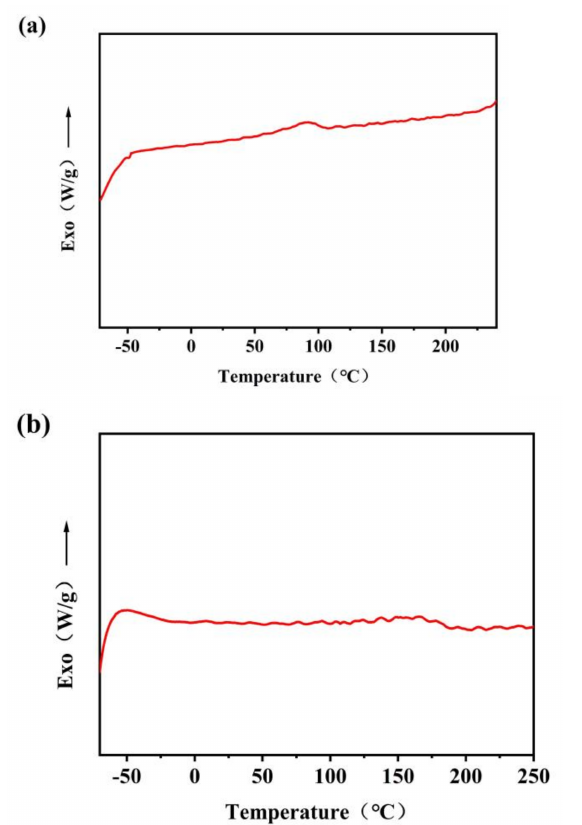
Figure 3. Differential scanning calorimetry (DSC) curves of TPSiU. ( a ) cooling curve. ( b ) secondary heating